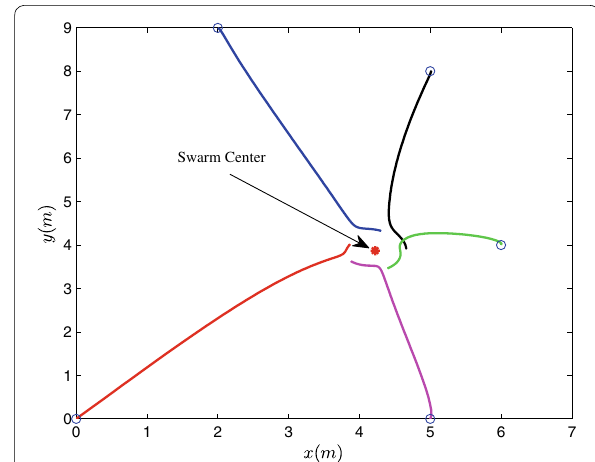
Figure 7 Trajectories of five robots under the constraint force Eq.